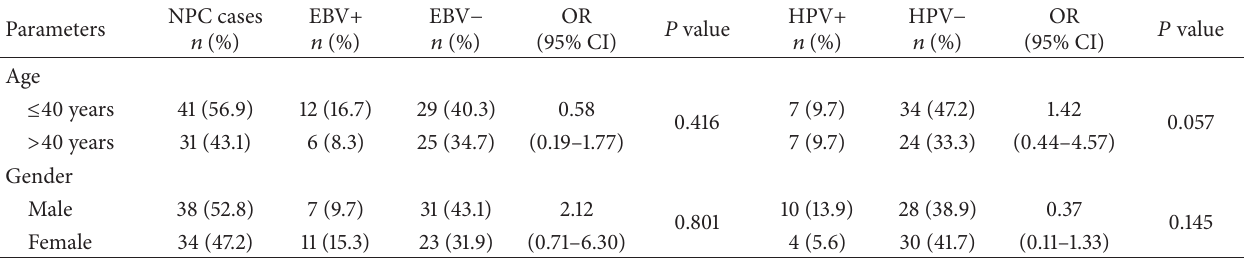
Table 1: Relationship between demographical parameters of NPC cases and EBV/HPV presence 𝑛 = 72 . Parameters